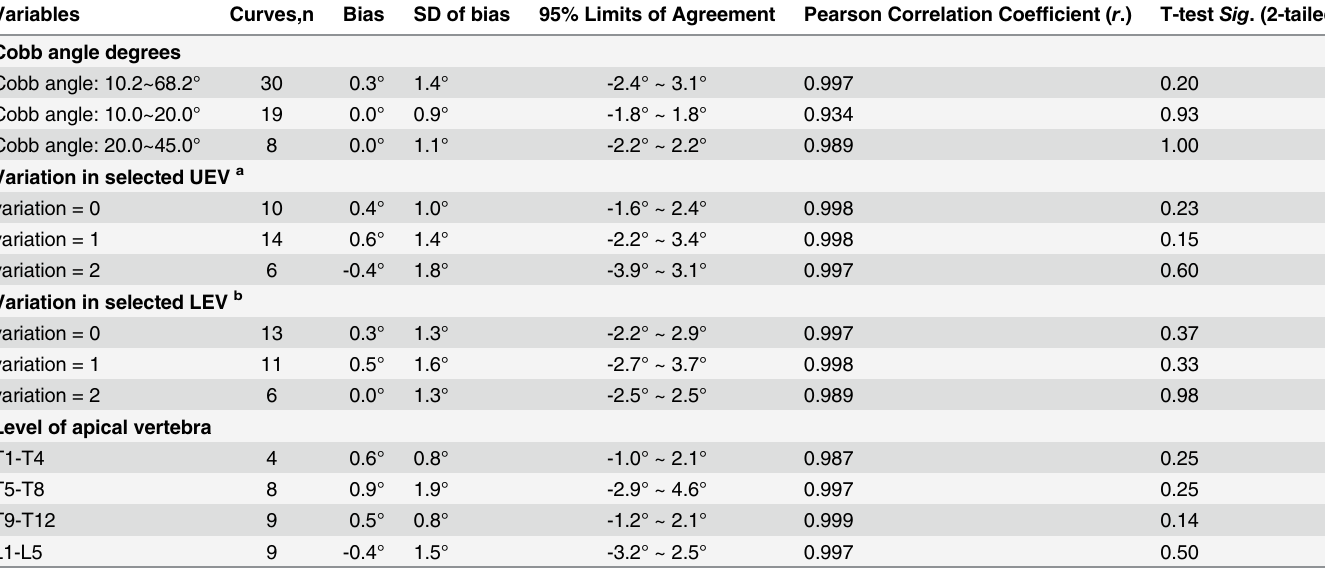
Table 3. Validation of coronal curvature assessments using ultrasound compared with MRI. Variables Pearson Correlation Coef fi cient ( r